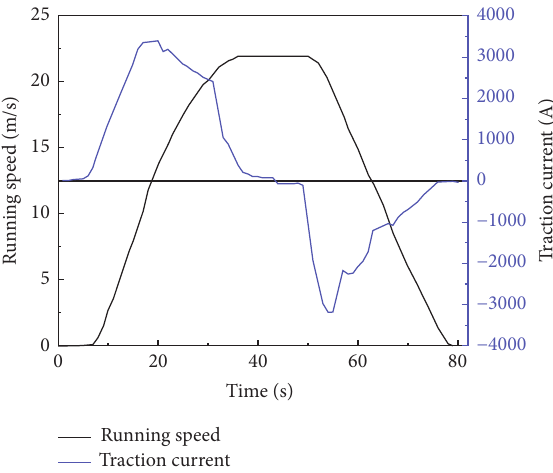
Figure 2: Train running speed and traction